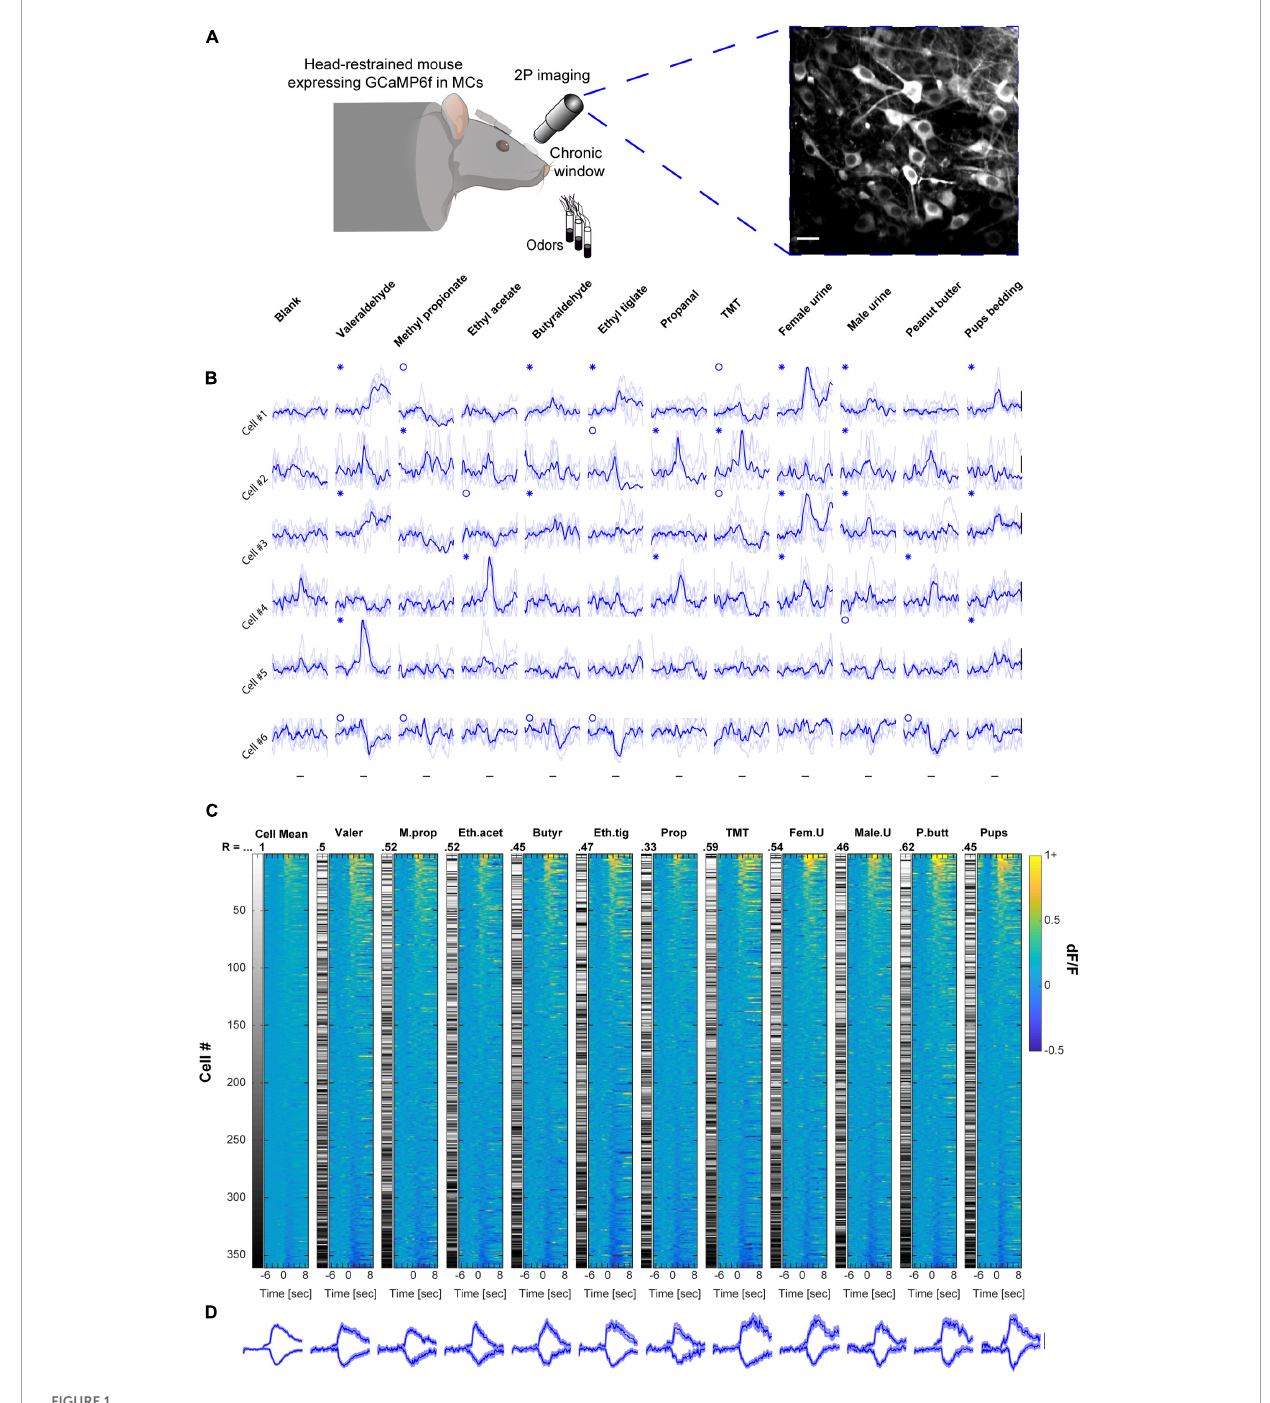
FIGURE1 Mitral cell (MC) responses in the awake state: balanced population response profile across odors. (A) Schematic illustration of the setup and a 2-photon micrograph of a representative field of MCs expressing GCamp6f. Scale bar = 25 µ m. Created with BioRender.com. (B) Examples of odor-evoked calcium transients in an awake mouse, from 6 MCs in response to 11 odors. Odor stimulation is denoted as a black horizontal line below all traces (2 s). Thin traces are five single trials; thick traces are means. Blue asterisks denote significant excited responses and blue circles denote significant suppressed response. Scale – vertical black lines, 30% dF/F. (C) Color coded columns shows all the data recorded from awake mice, sorted by magnitude per each stimulus separately. Greyscale columns - Ranks of Cells’ average response fitted to each cell-odor pair. Spearman correlation coefficients denote the rank correlation between the MC population average response and the population response to each one of the odors. Full odor names are depicted in panel (B) . Left color column (“Cell Mean”) depicts the mean response magnitude of each cell for the different odors. The left greyscale column, serves as a scale bar of cell identity. (D) Average traces of population S and E responses for each of the odors presented. Scale – vertical black line, 20% dF/F. Traces are presented as mean response (thick lines), and shadows are the SEM. Each trace represents 7 s pre-stimulus, 2 s stimulus presentation, and 7 s